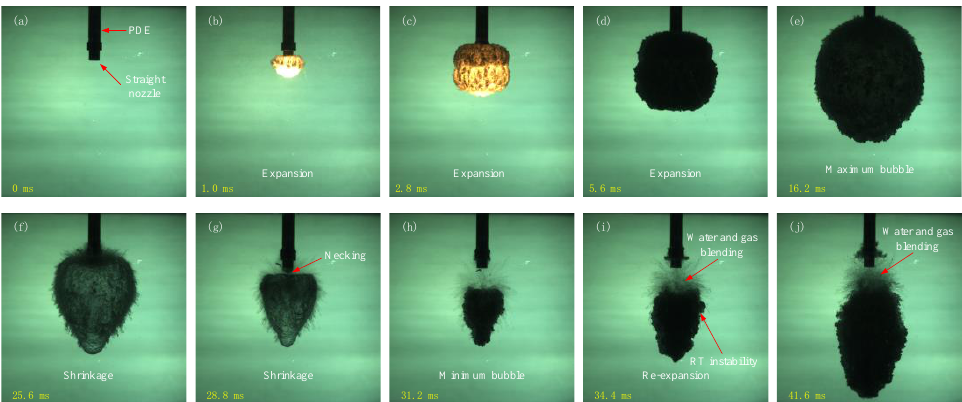
Figure 4. Bubble evolution process when the straight nozzle was installed: ( a ) t = 0 ms, ( b ) t = 1.0 ms, ( c ) t = 2.8 ms, ( d ) t = 5.6 ms, ( e ) t = 16.2 ms, ( f ) t = 25.6 ms, ( g ) t = 28.8 ms, ( h ) t = 31.2 ms, ( i ) t = 34.4 ms, ( j ) t = 41.6 ms.